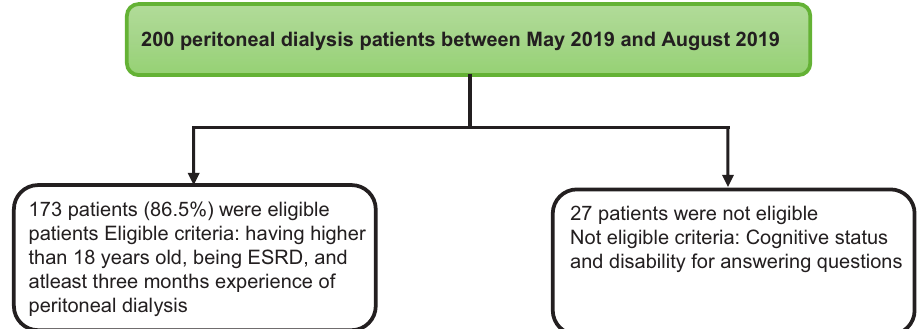
Figure 1: Study flow chart showing the inclusion and exclusion criteria of patients.